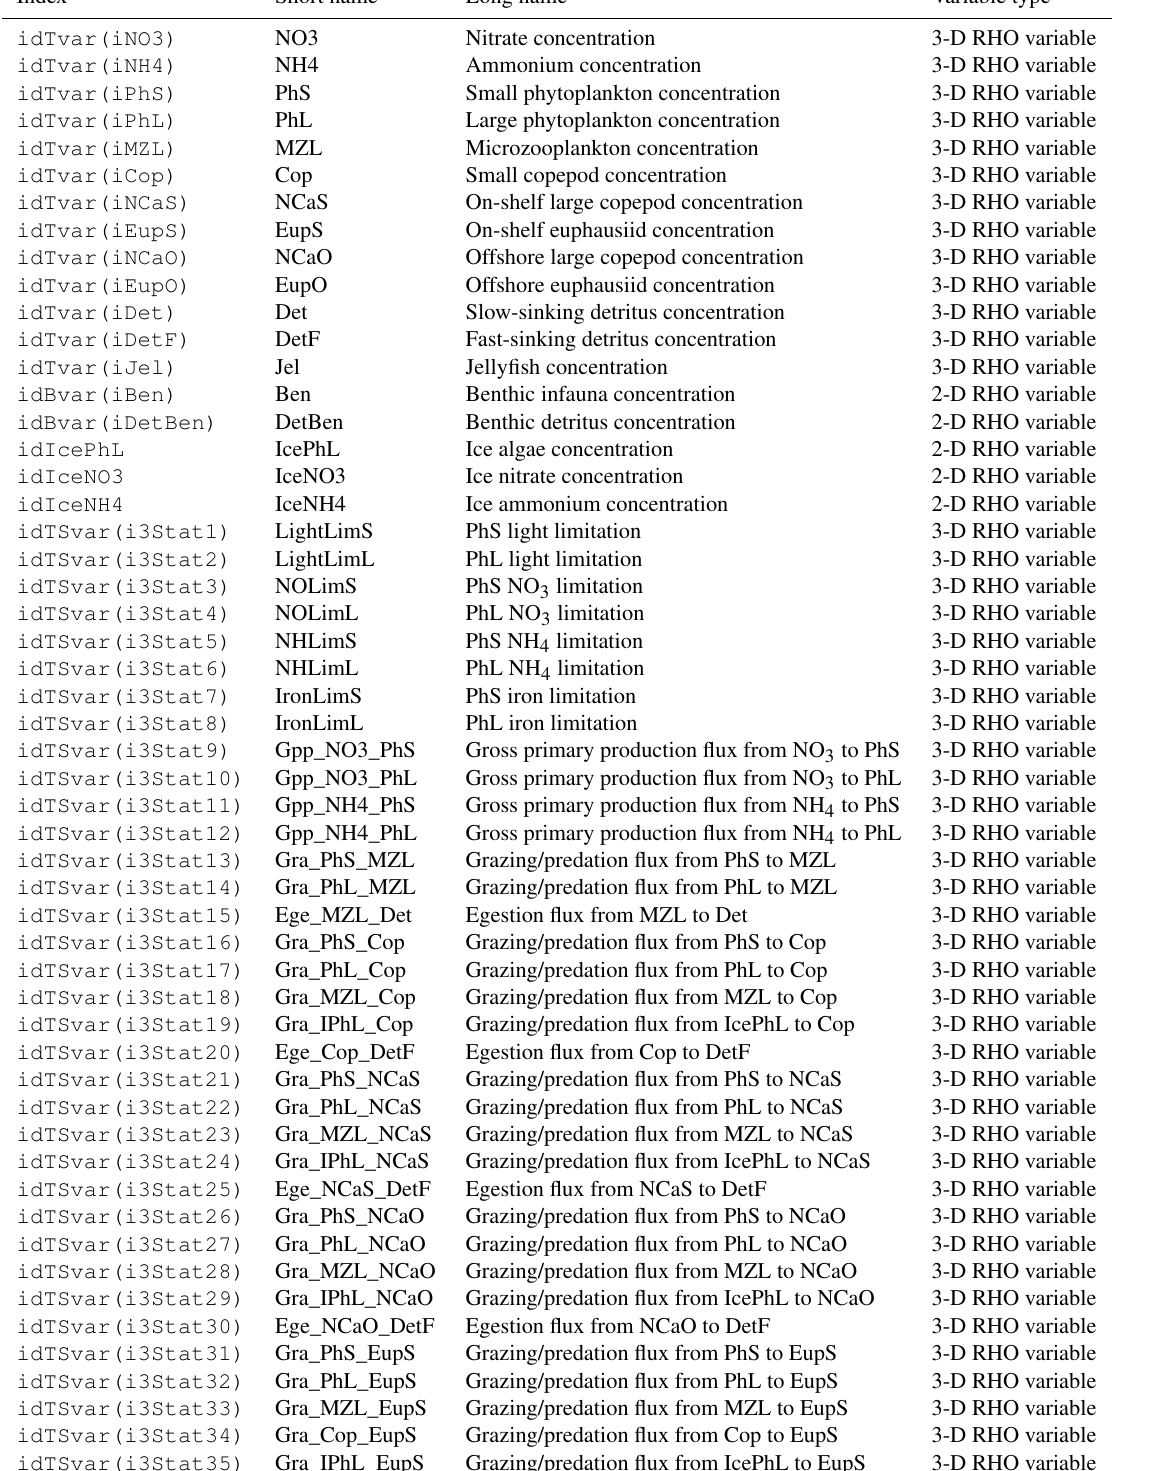
Table C3. Output variables available in the BEST_NPZ and FEAST models. The variable type indicates whether each variable is two- or three-dimensional, and whether they are located in the center of each grid cell ( ρ ), on the corners ( ψ ), or along an edge ( u or v ); currently, all biological variables are ρ